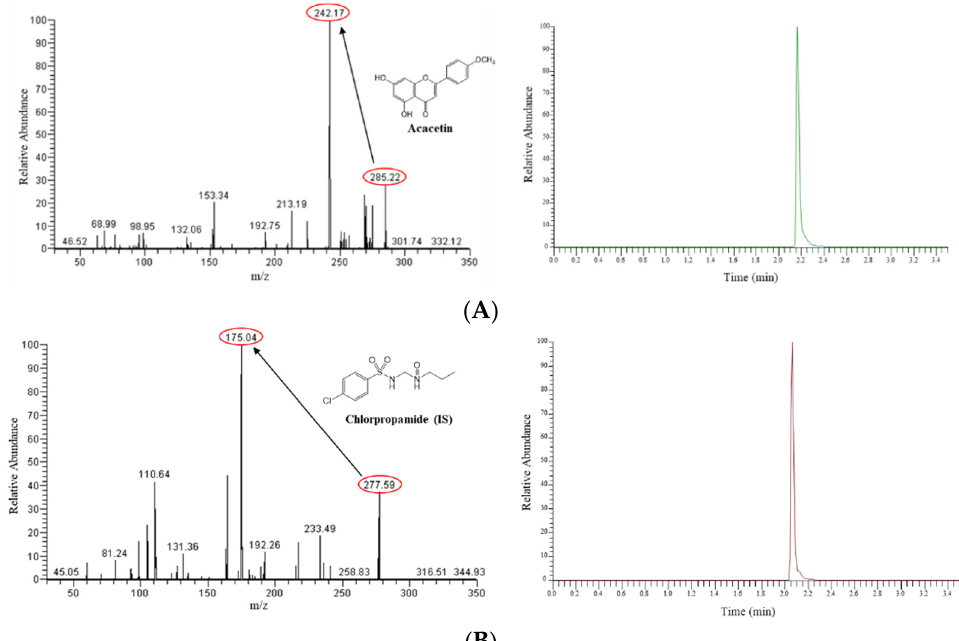
Figure 1. Representative product ion scan spectra (left side) and mass chromatograms (right side) of acacetin ( A ) and the internal standard (IS) ( B ) in rat plasma samples spiked with acacetin at high quality control level.